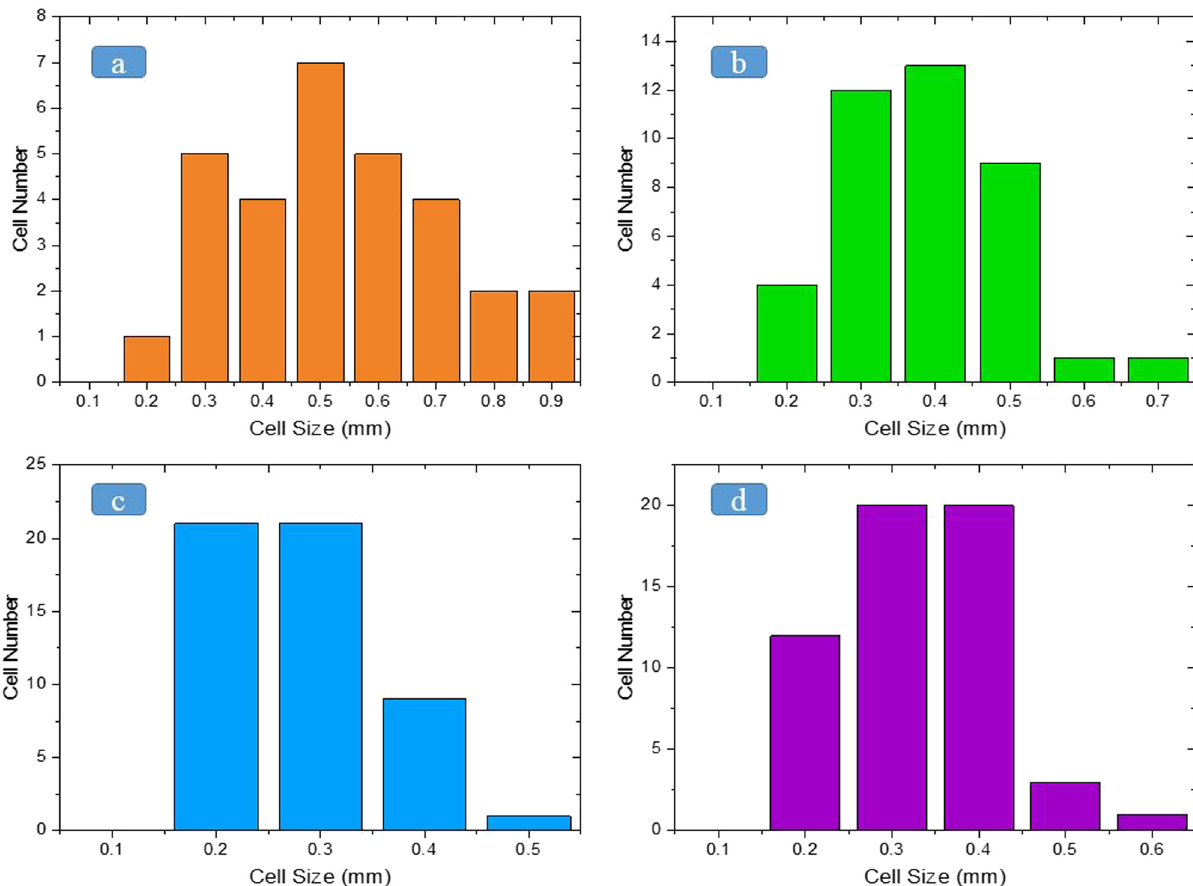
Figure 7: Distribution of cell size of foams prepared by route 2: ( a ) S10, ( b ) S20, ( c ) S30, and ( d ) S40.